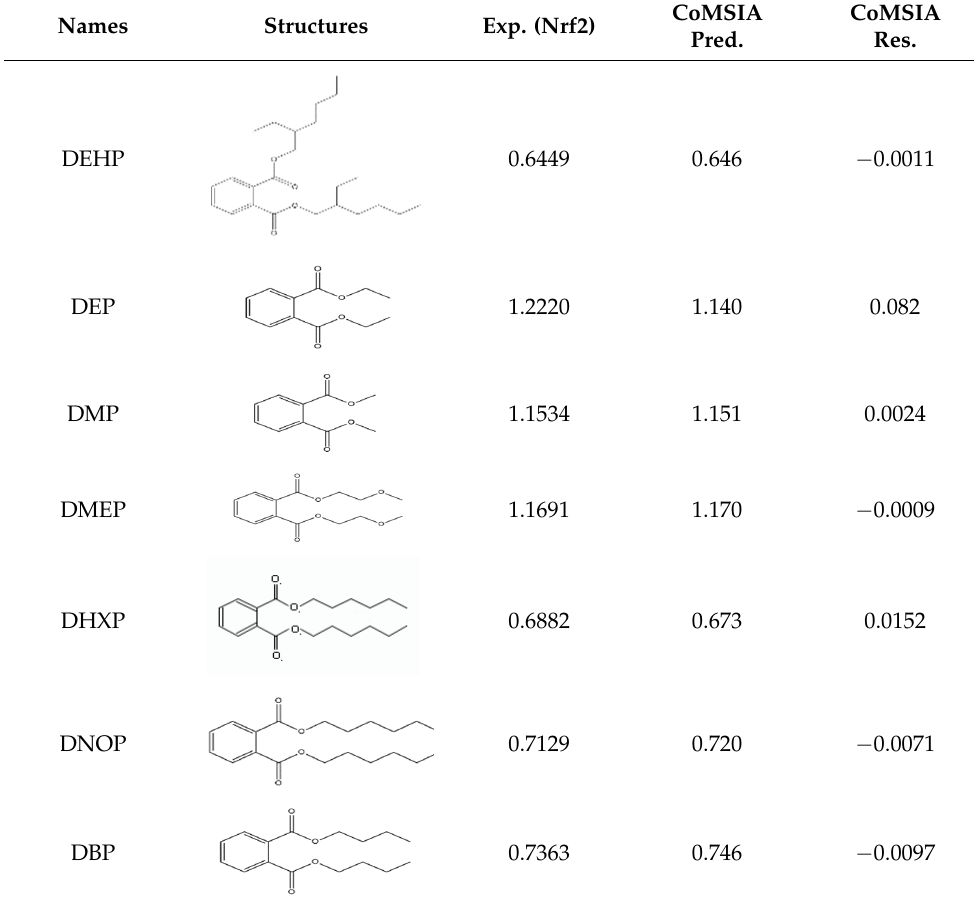
Table 4 Actual value, predicted value and error of 3D-QSAR model of PAEs on cell Nrf2 content. Structures